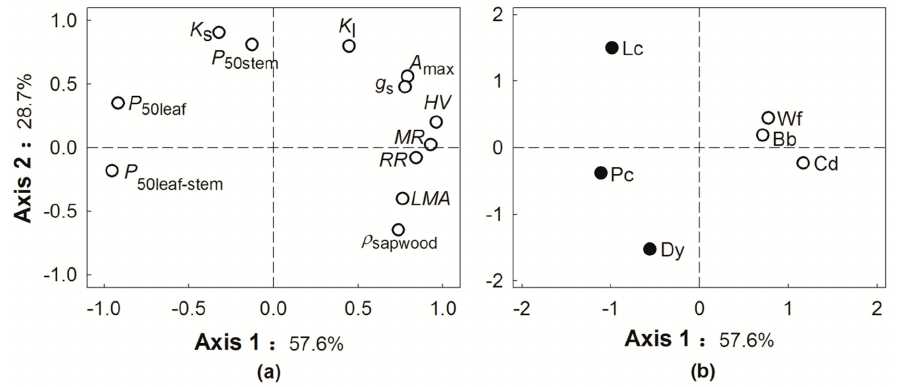
Figure 3. Principal component analysis (PCA) for twelve functional traits ( a ) and six tree species ( b ). The abbreviation of functional traits and species codes are shown in Table 1 and Figure 1, respectively. The hollow and solid circles in Figure 3b indicate the NS species and VS tree species,